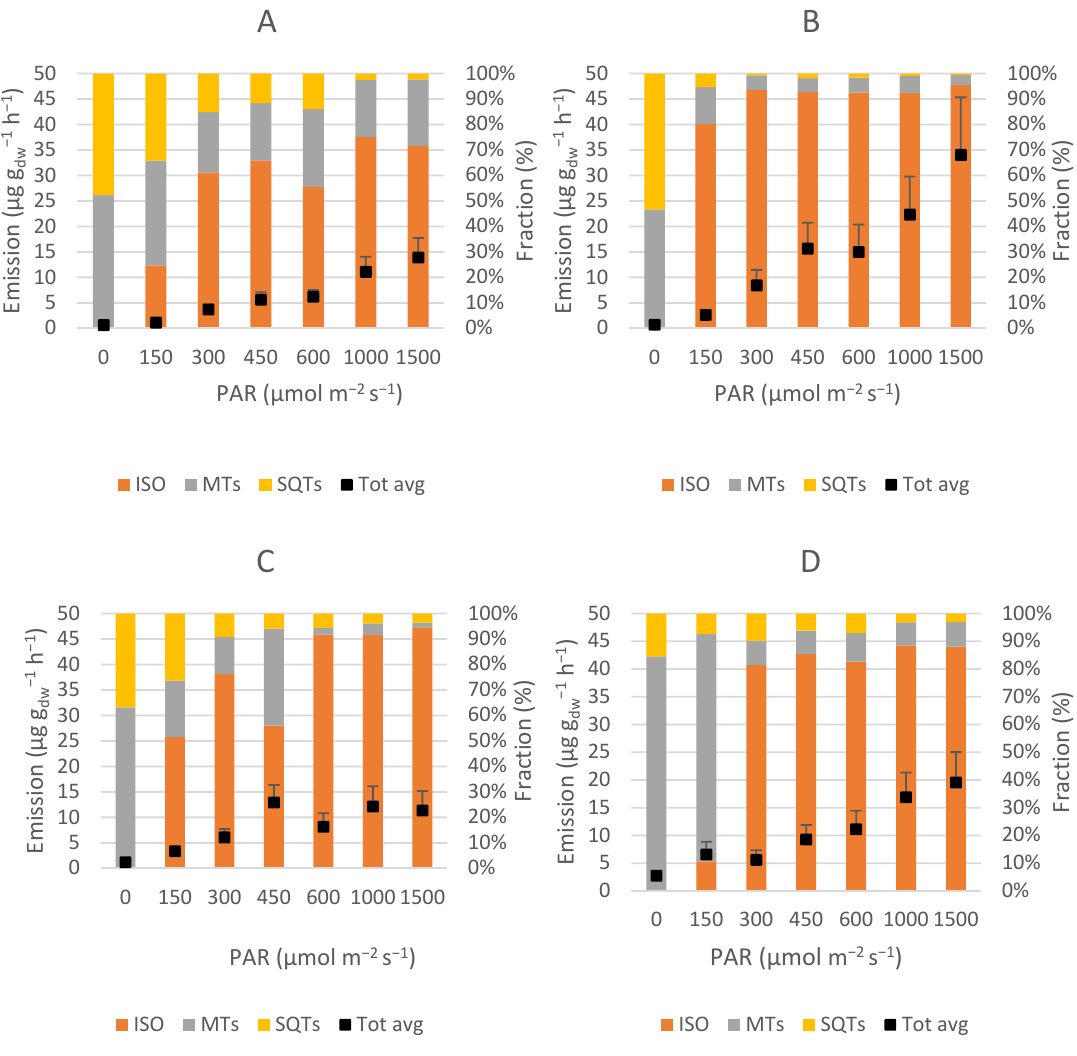
Figure 5. Total terpenoid emissions (black squares, µg g dw − 1 h − 1 , mean + standard deviation, n = 7–16) and the fraction of isoprene (ISO), MTs and SQTs for different PAR values (µmol m − 2 s − 1 ). ( A ) Tora, ( B ) Wilhelm, ( C ) Ester and ( D ) Inger.